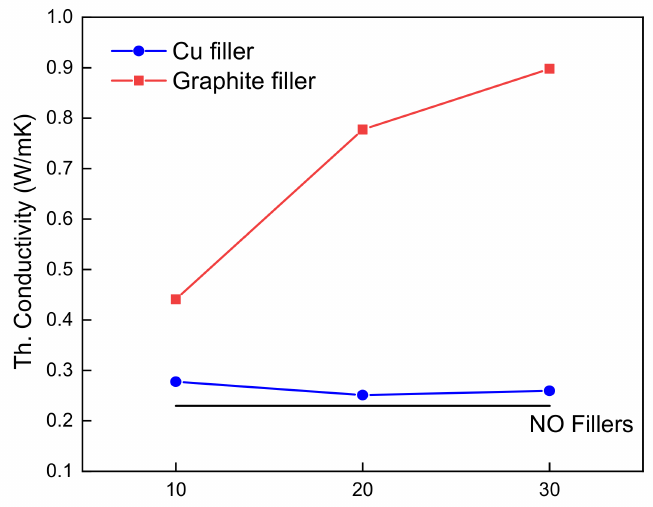
Figure 12. Thermal conductivity graph by amount and type of fillers.